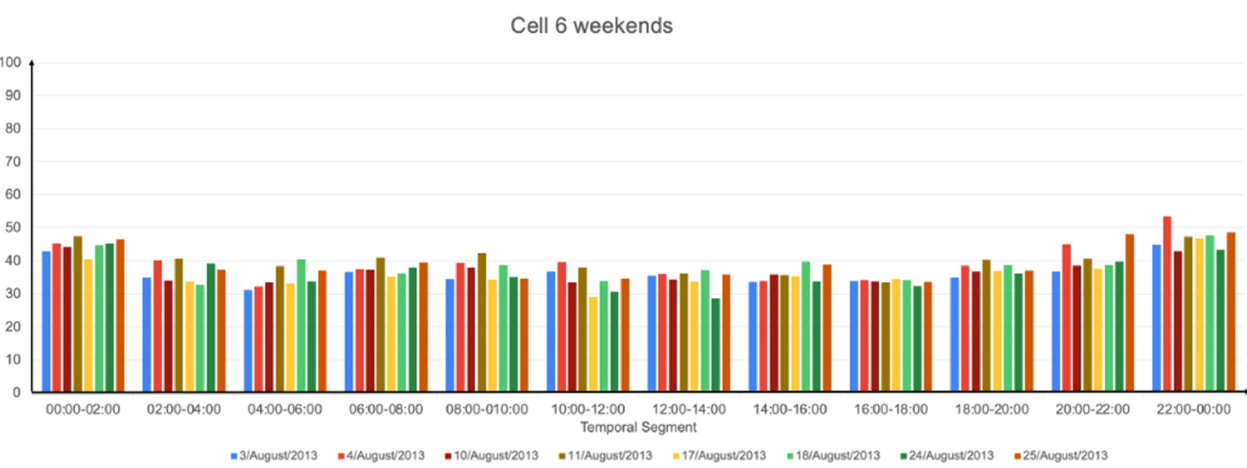
Figure 15. Calculated SPI for the entire month, cell 6 with Vmax = 100 km/h in the afternoon.